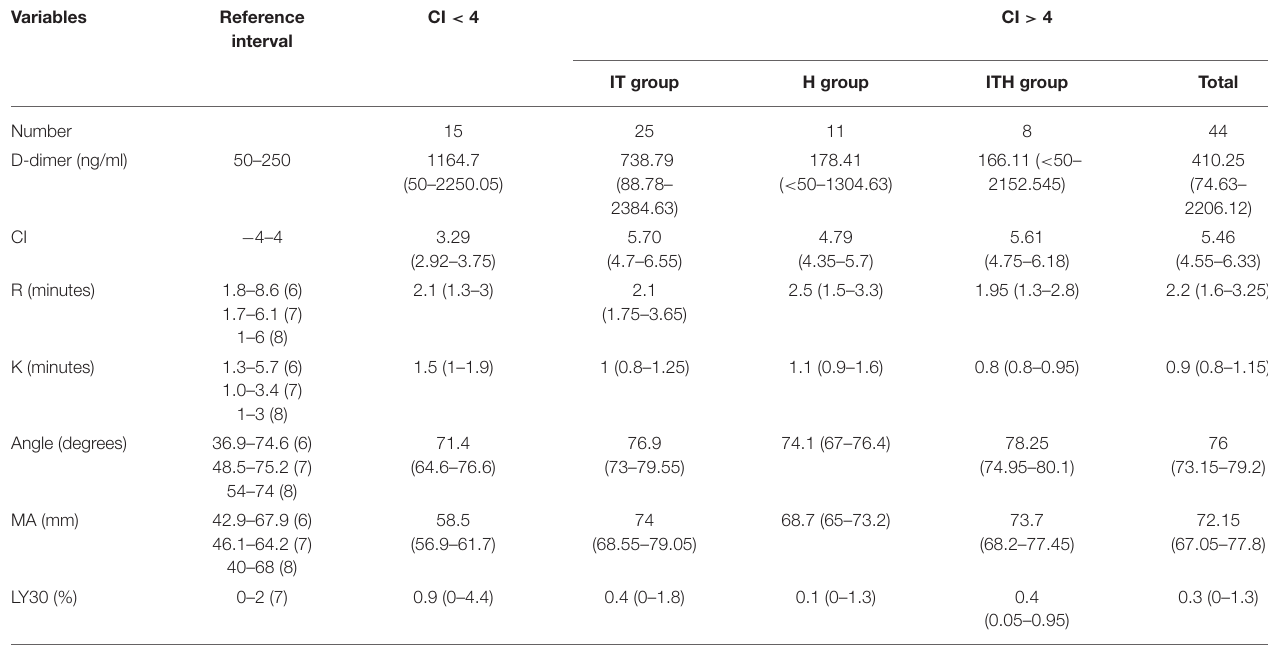
TABLE 1 | Median values (interquartile ranges) of the D-dimer concentration, coagulation index, and thromboelastographic results in 59 dogs with critical illness, consisting of 44 dogs with CI > 4 and 15 dogs with CI < 4.